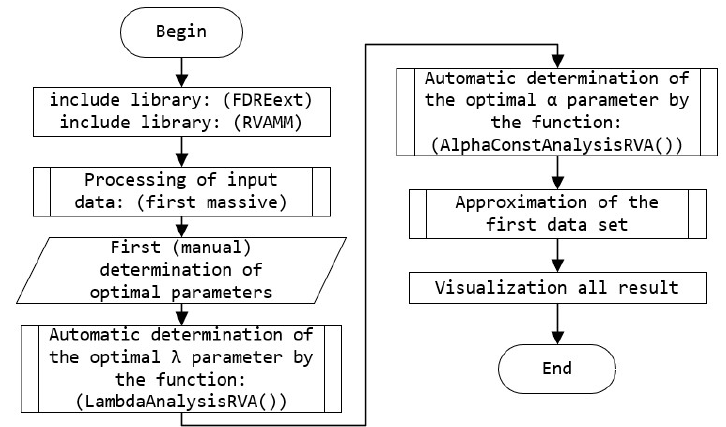
Figure 7. Block diagram, executable file for RVA simulation task.